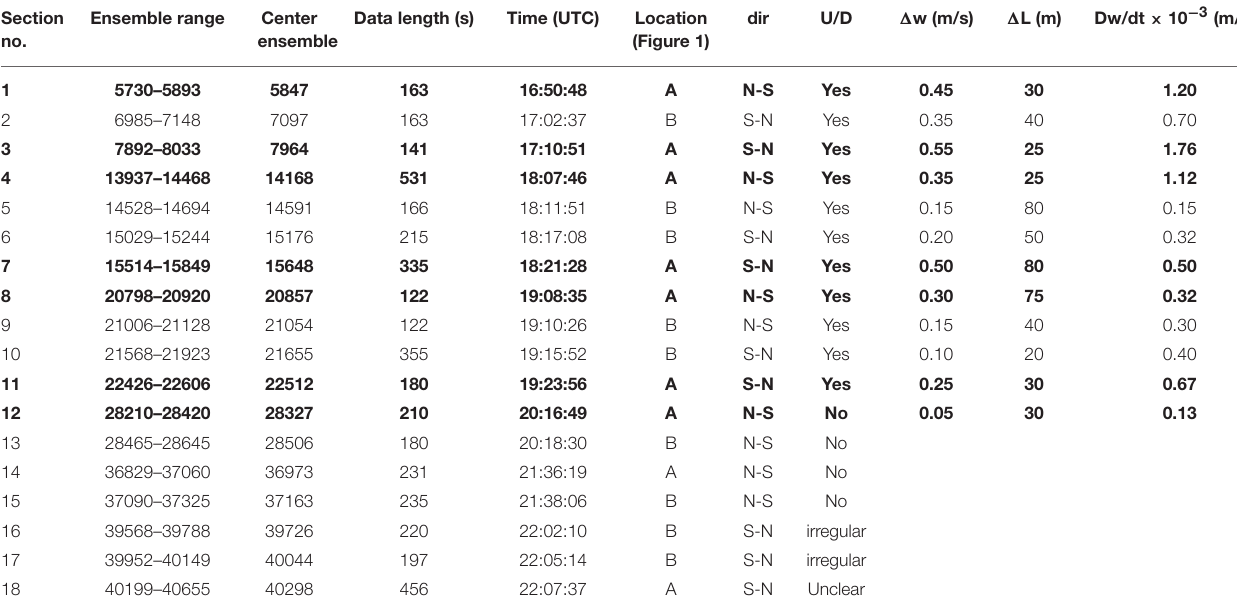
TABLE 1 | Crossing of the Scour holes. Section no.